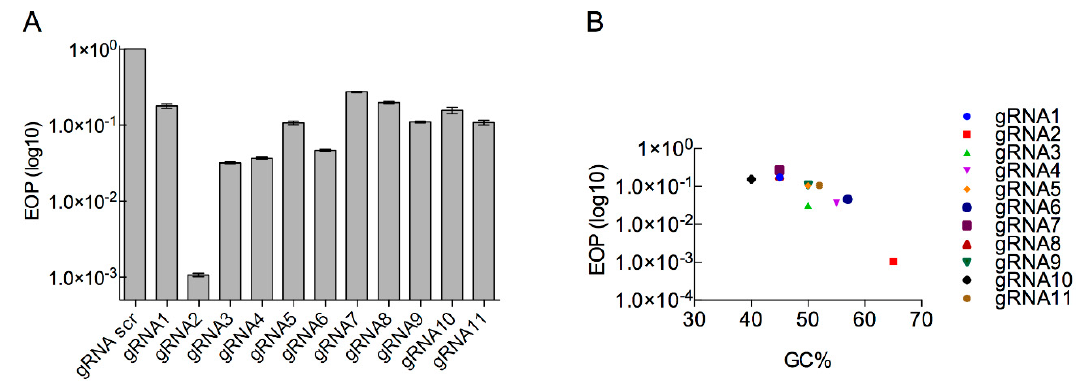
Figure 5. Efficiency of gRNA candidates as marker-less selection system in type II CRISPR-Cas system. ( A ) Efficiency of plating (EOP) for T7 against E. coli BW25113 containing type II CRISPR gRNAs. The EOP was determined with respect to a reference E. coli strain BW25113/pCas9. EOP data are presented as the mean of three independent experiments. ( B ) EOP data plotted against GC% of each gRNA.